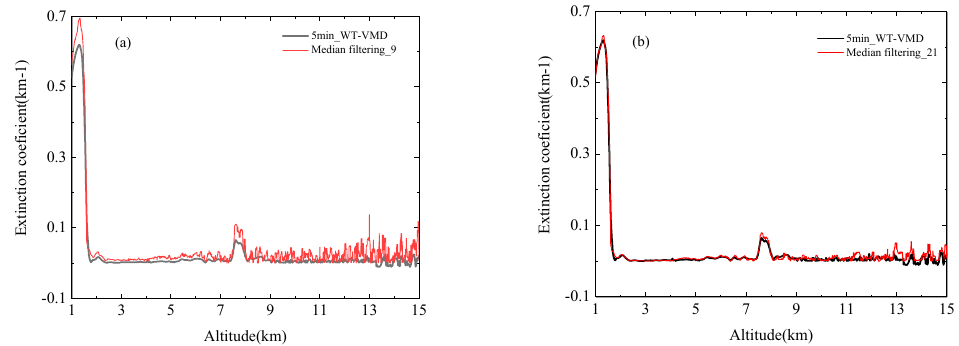
Figure 13. Comparison of extinction coefficient between median filtering method and WT-VMD method ( a ) median filtering_9 vs. 5 min WT-VMD denoising; ( b ) median filtering_21 vs. 5 min WT-VMD denoising.